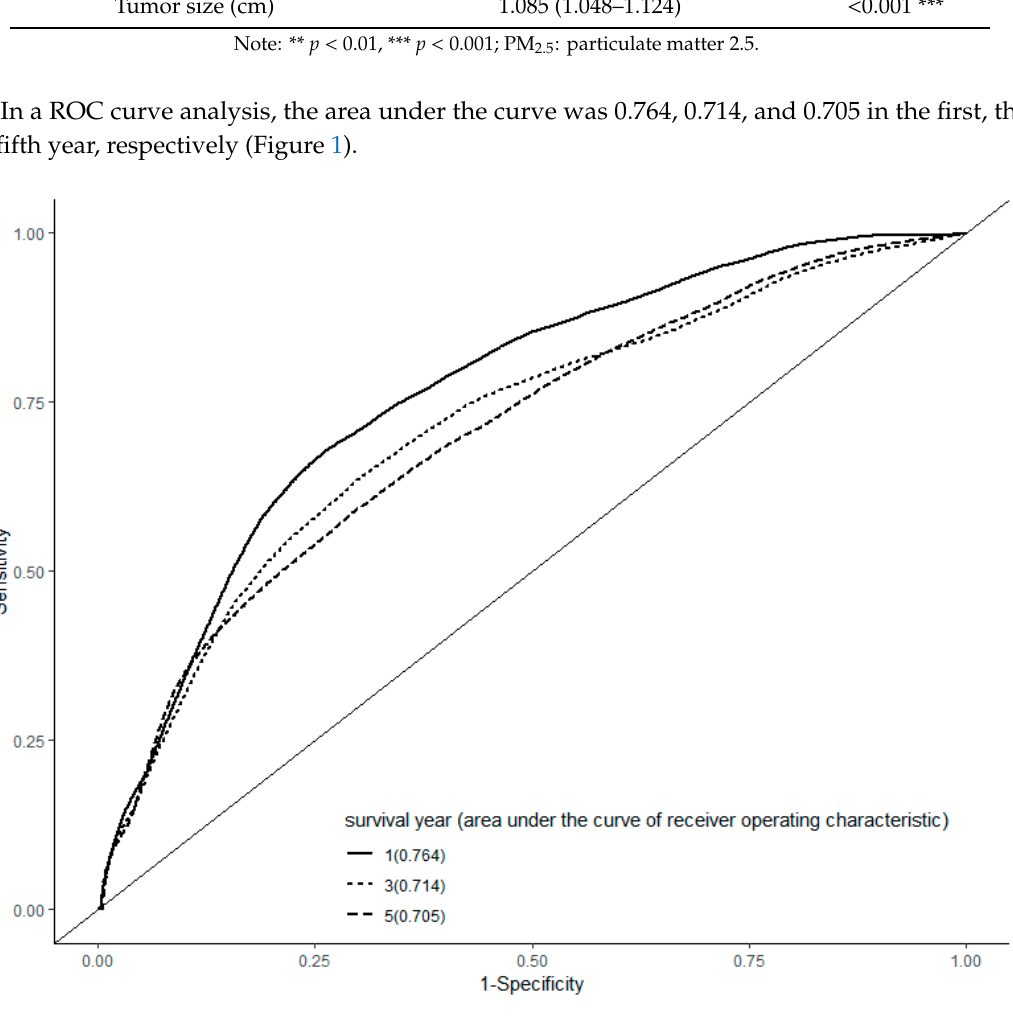
Figure 1. Receiver operating characteristic curve analysis. The area under the curve was 0.764, 0.714, and 0.705 in the first, third, and fifth year after the diagnosis of hepatocellular carcinoma, respectively.